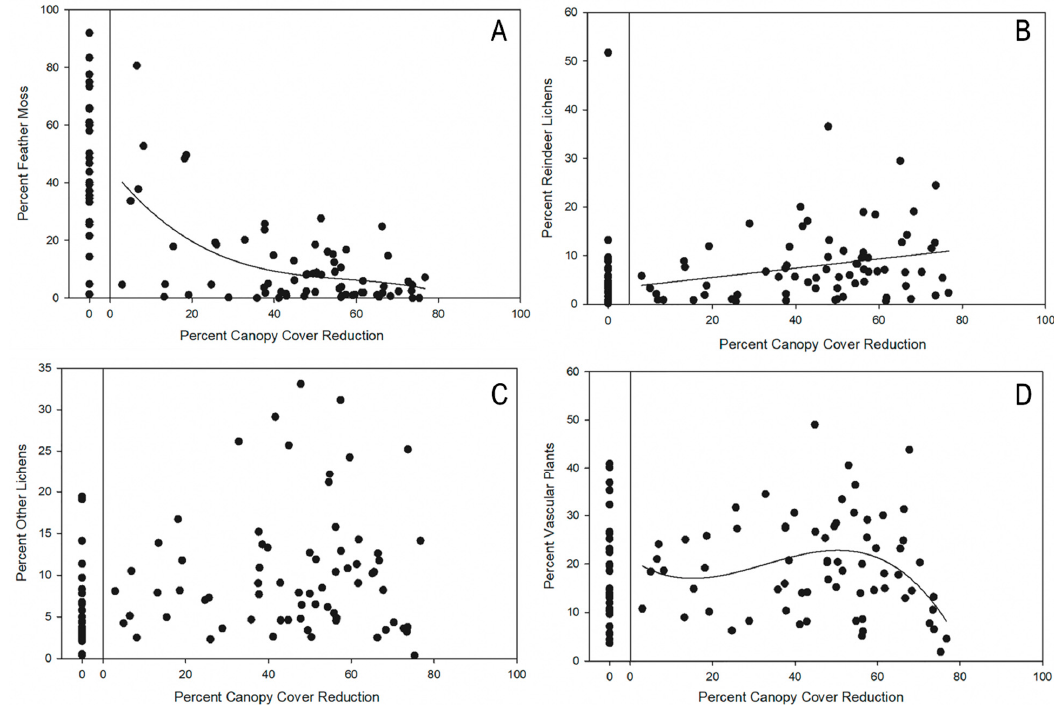
Figure 2. Regression of percent cover of: ( A ) feather mosses, (R 2 = 0.340, p < 0.0001, f = 45.2 + ( − 1.8)*x + 0.03*x 2 + ( − 0.0002)*x 3 ). ( B ) Reindeer lichens (R 2 = 0.070, p = 0.028, f = 3.6 + 0.1*x). ( C ) Other lichens ( p = 0.199). ( D ) Understory vascular plants (R 2 = 0.12, p = 0.043, f = 21.2 + ( − 0.6)*x + 0.03*x 2 + (-0.0003)*x 3 )